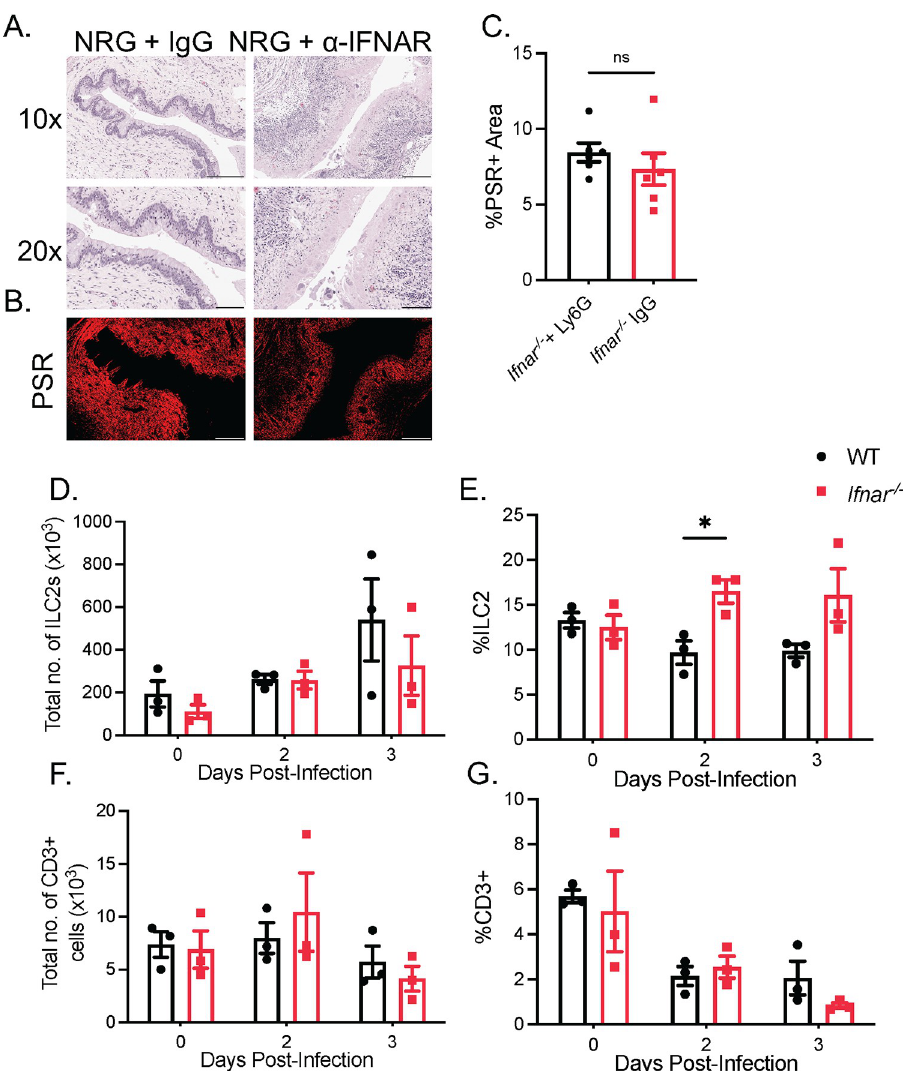
Fig 2. Vaginal immunopathology in Ifnar -/- mice is independent of ILC2s or TH2 CD4 + T cells. (A) H&E staining of vaginal cross-sections of NRG mice + α -IFNAR or isotype control 3 dpi (n = 5). (B and C) PSR staining (B) and quantification of PSR+ to total vaginal tissue (C) of NRG mice + α -IFNAR or isotype control 3 dpi (n = 5). (D and E) Total number of CD45+Lin-ST2+CD90.2+ ILC2s (D) and proportion of ILC2s to total CD45+ cells (E) in vaginal tissue of WT and Ifnar -/- mice following HSV-2 infection (n = 3). (F and G) Total number of CD3+ T cells (F) and proportion of CD3+T cells to total CD45+ cells (G) in vaginal tissue (n = 3). 10x scale bar represents 200 μ m, 20x and PSR scale bar represents 100 μ m. Data in (C) to (D), (E), (F), and (G), are represented as mean ± SEM. � p < 0.05. (D-G, two-way ANOVA; C two-tailed t test) See also S2